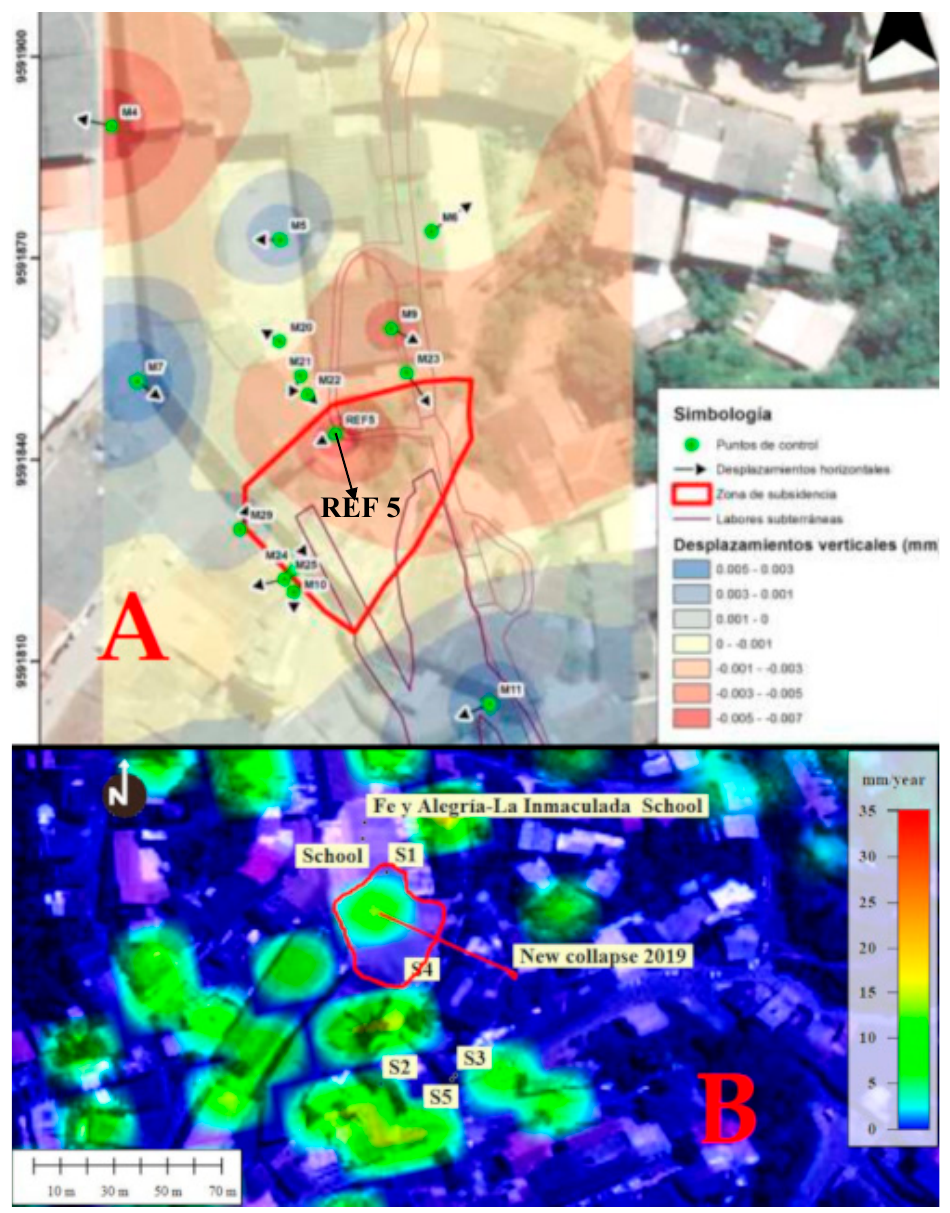
Figure 13. Correlation between the results obtained from areas of subsidence by InSAR Interferometry with the geotechnical investigations of subsidence carried out by INIGEMM and the author of the thesis [37]. Image 13A has low resolution since its origin. Note the correlation between the sinking areas CF5 of Figure 13 ( A ) and the new collapse occurred at the same site in 2019 of Figure 13 ( B ). S1 to S2 surveys conducted by INIGEMM.